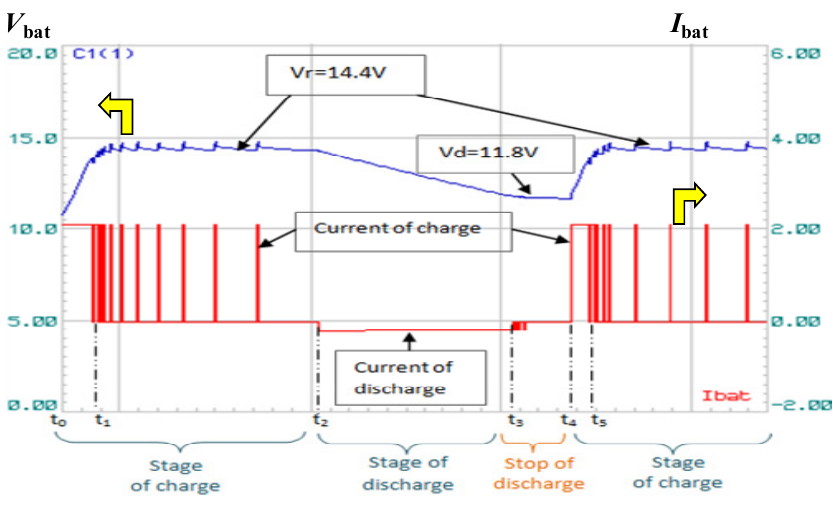
) and current ( I ) of charge/discharge bat bat